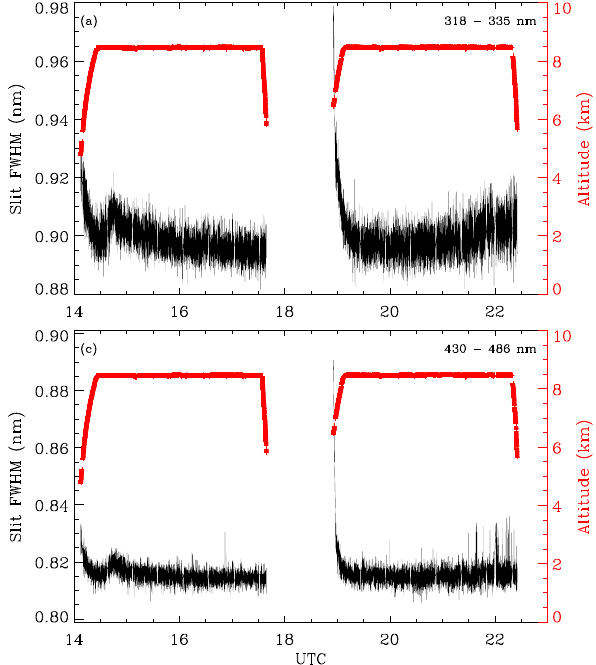
Figure 3. Time series of derived slit full width at half maximum (FWHM, black line) for the O 3 (318–335nm) and NO 2 (430– 486nm) fitting windows from ACAM data from 21 July 2011. The red symbols indicate the corresponding flight